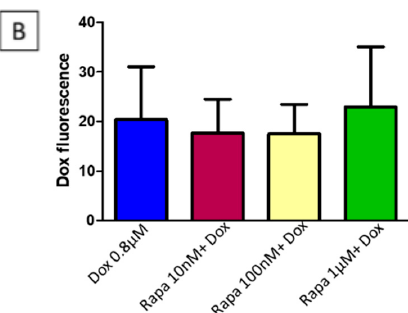
Figure 2. Effect of Rapa on Dox uptake in MDCKII P-gp transfected cells. ( A ) Cellular uptake of Dox by flow cytometry. Each peak represents the mean fluorescence intensity of Dox (0.8 µM) in control and treated samples; ( B ) No significant difference can be observed comparing Dox fluorescence signals between cells treated with Dox (0.8 µM) vs. Rapa plus Dox. Statistical analysis was performed by 1-way ANOVA followed by Bonferroni post hoc correction. Data were expressed as mean ± SD. This experiment was performed two times in triplicate.